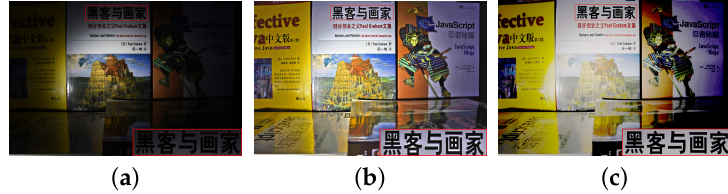
Figure 1. The low-light image and enhanced images are some of technical books about Java. ( a ) is a low-exposed image; ( b ) is obtained by low-lighting image enhancement (LIME) [10]; ( c ) is obtained by the inaccurate intensity mapping function (IMF). Clearly, brightness change is possible issues for the former. Color distortion and noise amplification are possible issues for the